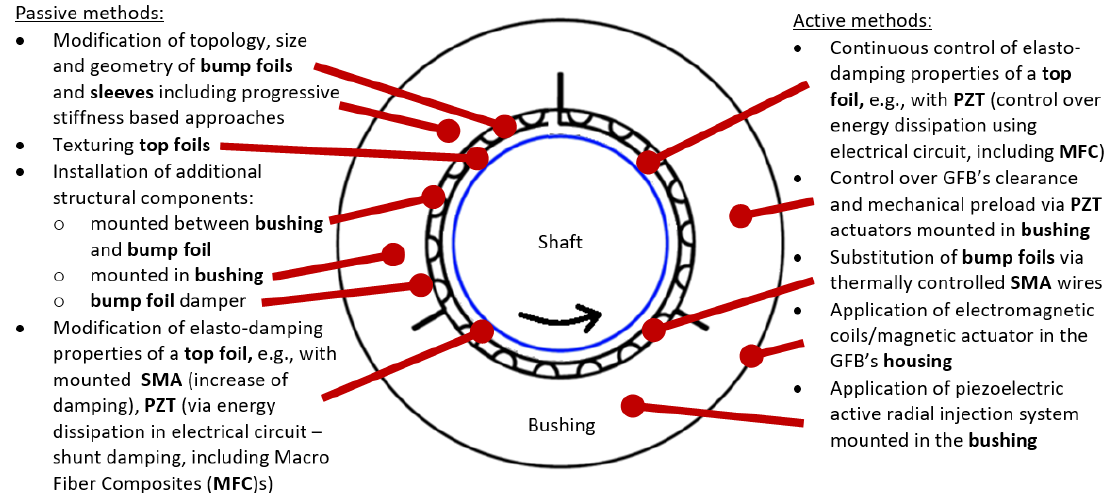
Figure 2. Scope of structural modifications in GFBs introduced to enhance the elasto-damping properties of the bearings. Various topology, size and geometric changes may be taken into account to improve the performance of GFBs. The modifications may affect both the bushing and specialized foils. Moreover, additional components (also made of smart materials) may be used to achieve an advantageous change in the bearing’s properties.